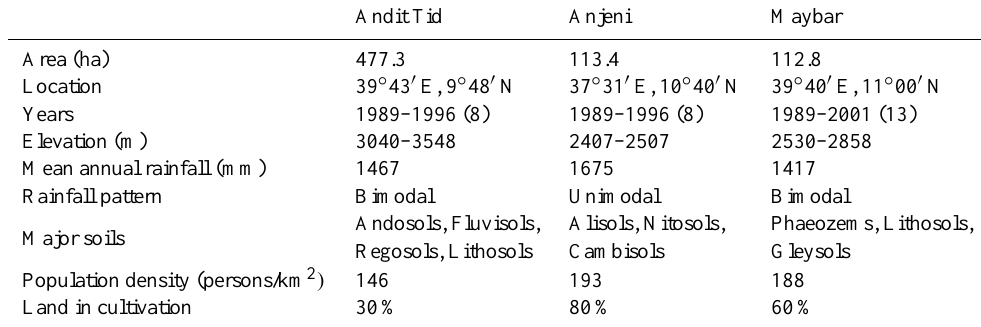
Table 1. Field site information (SCRP, 2000a, b, 2001; Yohannes, 1989; Leggesse, 2009; Hurni et al.,